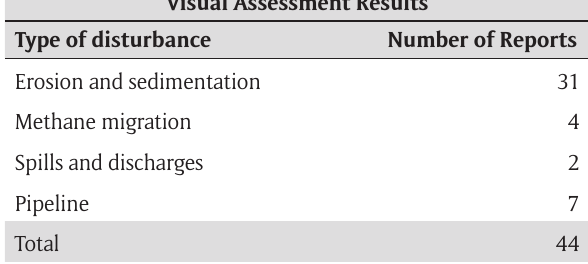
Table 3: Compilation of visual assessment results. Compiled by Julie Vastine, Director of ALLARM, 2015.